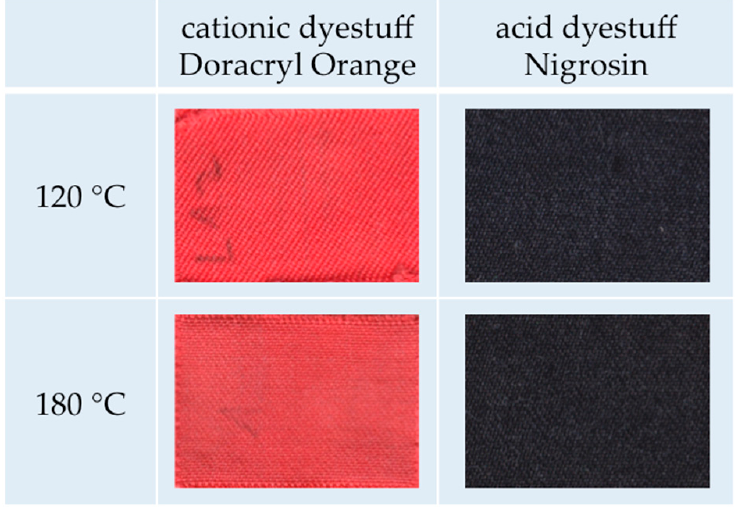
Figure 9. Dyeing of amorphous m-aramid fabrics with cationic dyestuff Doracryl Orange and acid dyestuff Nigrosin in EMIM-EtSO 4 at 120 °C and 180 °C, respectively.